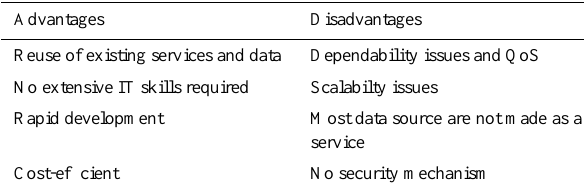
Table 1. Mashups Pro and